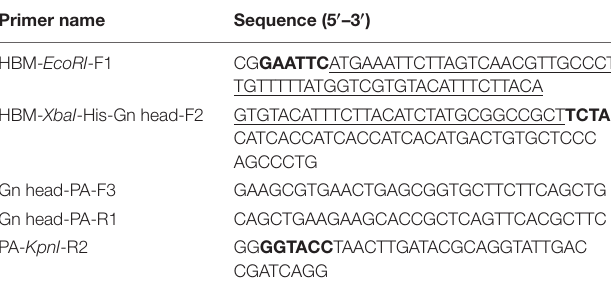
TABLE 1 | Sequences of the primers used in the present